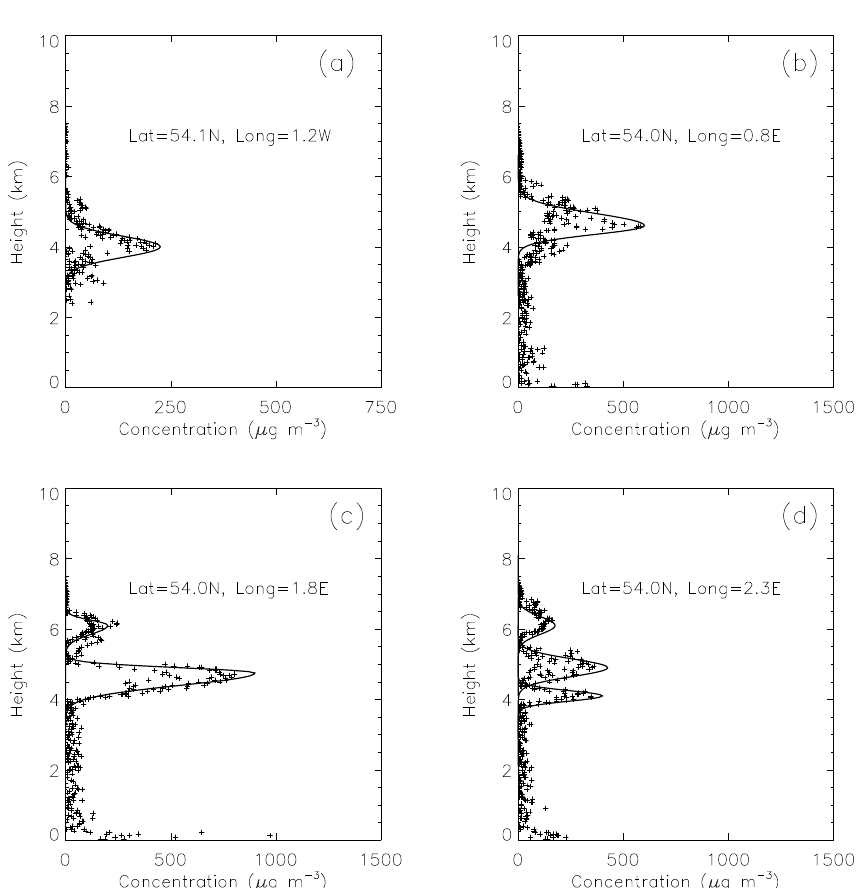
Fig. 2. Examples of concentration profiles derived from lidar between 14:00 and 15:00UTC on the 17 May. The crosses show the concentration estimates from the lidar, the solid curves show the Gaussian curves that have been fitted to the observations by eye.